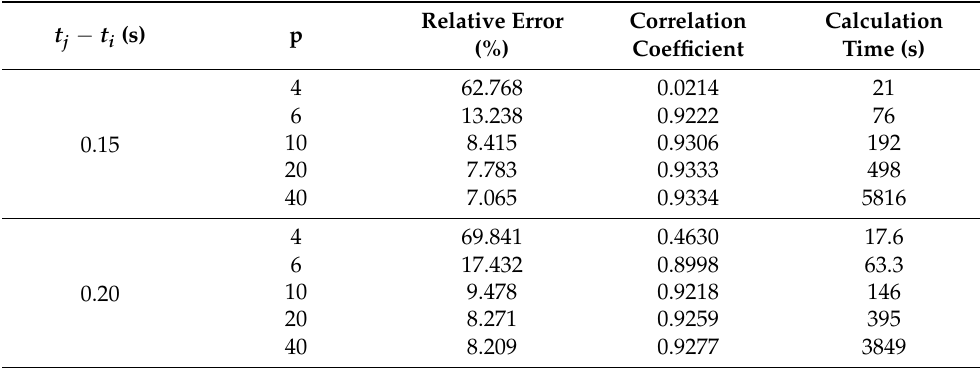
Table 4. Load identification results of various